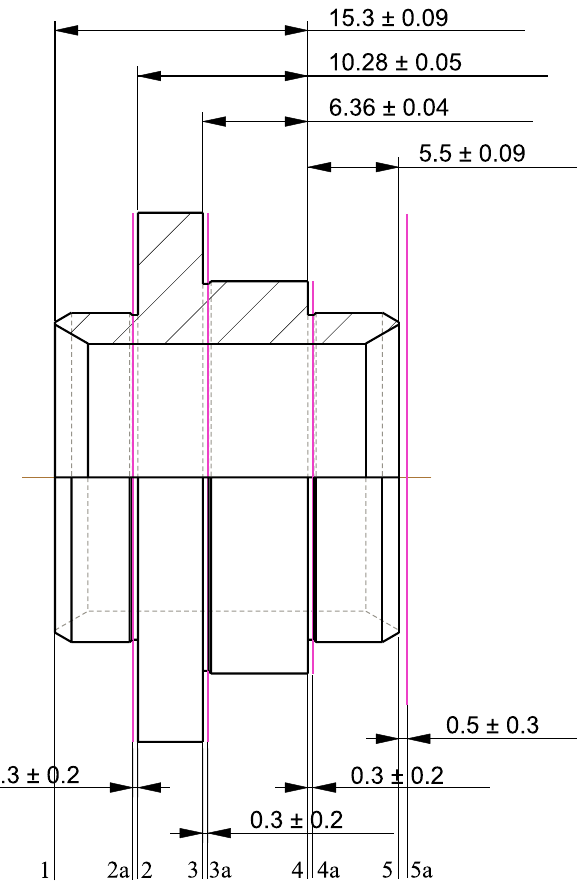
Fig. 1. The industrial part with four design dimensions and four stock removal